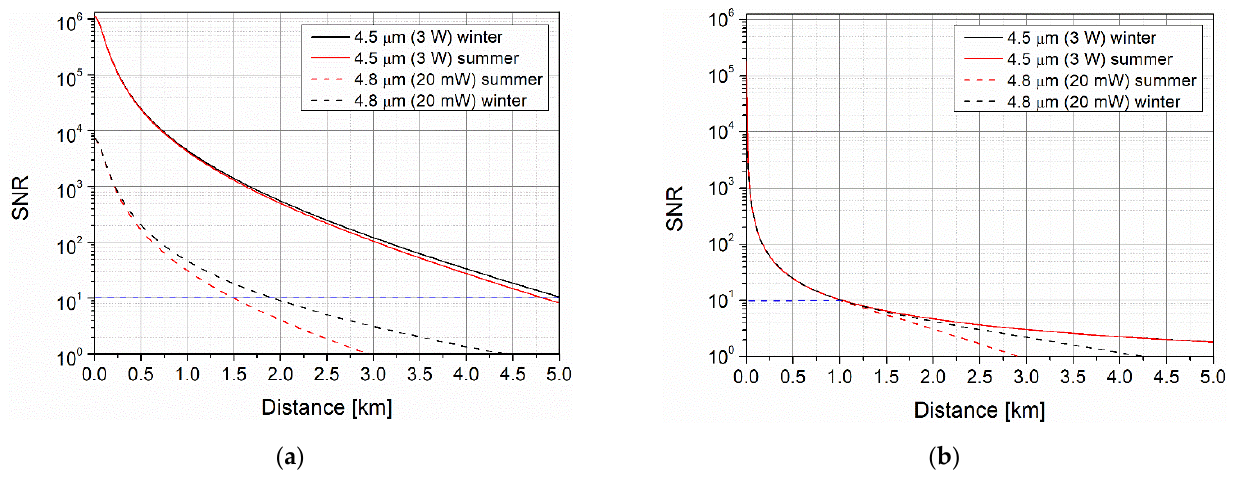
Figure 7. The signal-to-noise ratio (SNR) value vs. data link range in the case of ( a ) no scintillation and ( b ) medium scintillation C n2 = 10 − 14 m − 2/3 .